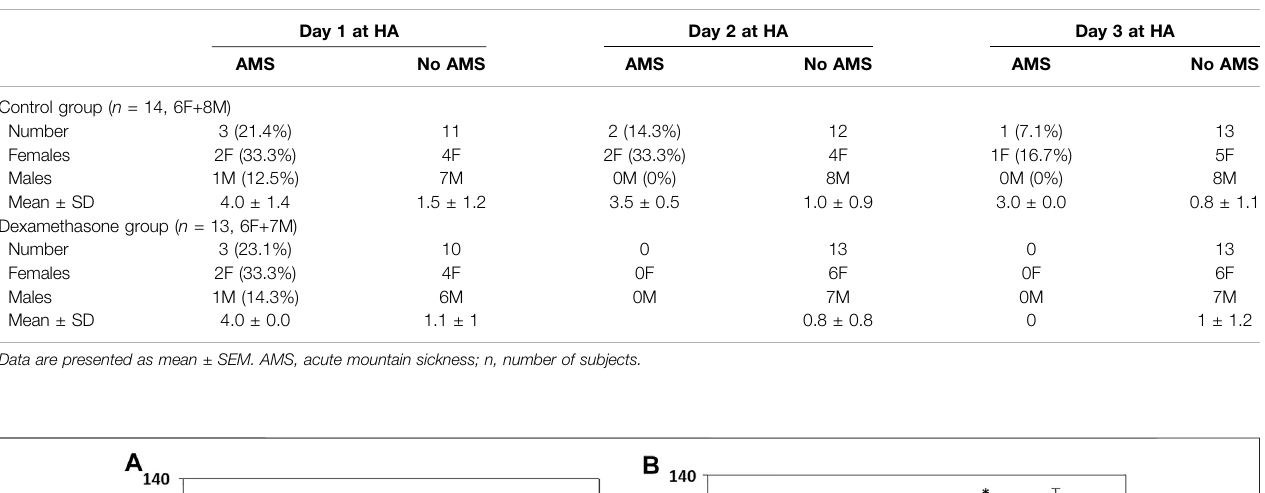
control group had a mean SBP elevation of 11.4 mmHg at HA compared to the same at LA ( p = 0.030), and the male dexamethasone group had a rise of 12.1 mmHg under similar comparisons ( Figure 1B , Supplementary Table S3B blue).